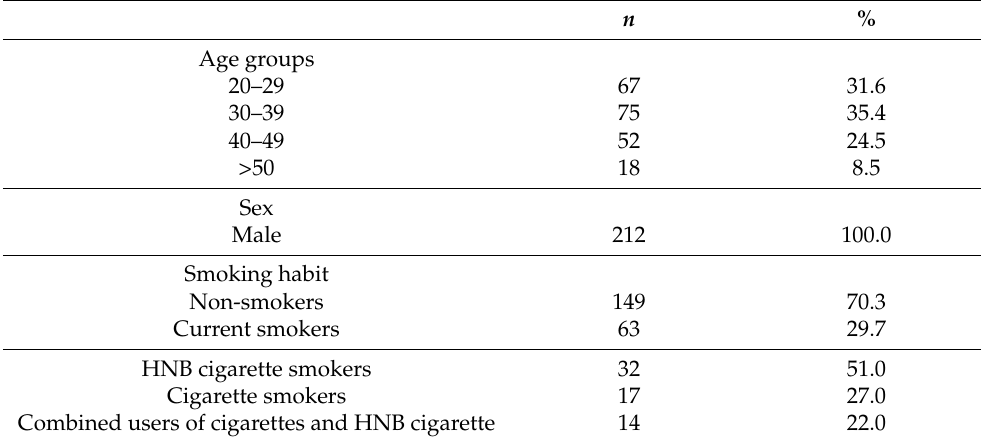
Table 1. Participant